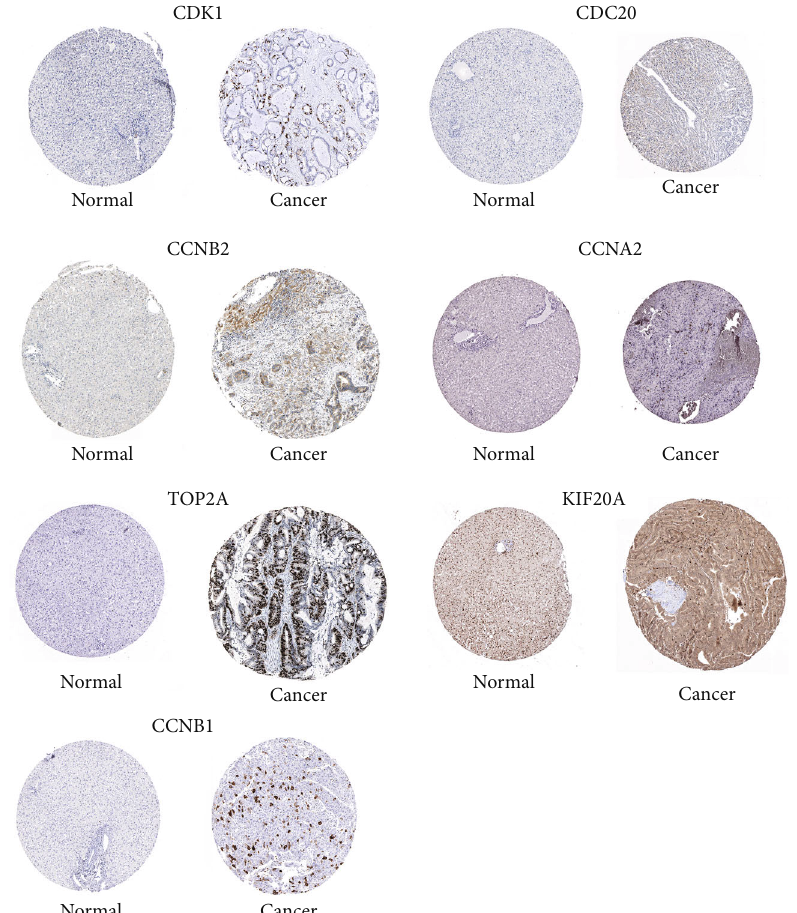
Figure 8: Protein expression of CDK1, CDC20, CCNB2, CCNA2, TOP2A, KIF20A, and CCNB2 in HCC and control tissues was evaluated using Human Protein